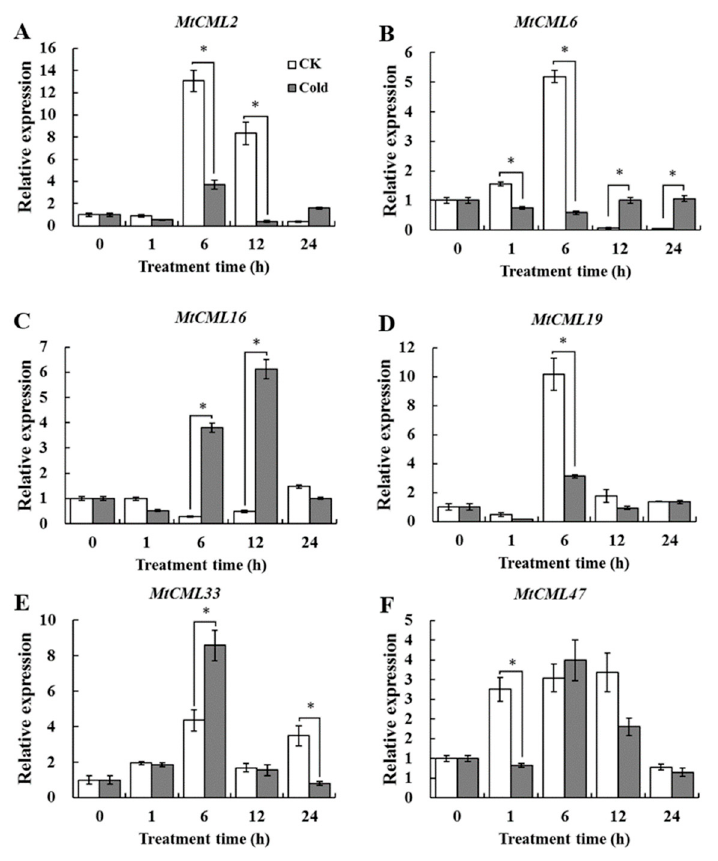
Figure 7. Relative expression of ( A ) MtCML2 , ( B ) MtCML6, ( C ) MtCML16, ( D ) MtCML19, ( E ) MtCML33 and ( F ) MtCML47 in response to cold treatment. Mean values and standard errors of three independent experiments presented. * indicate significant difference between cold treatment and control at p < 0.05 .